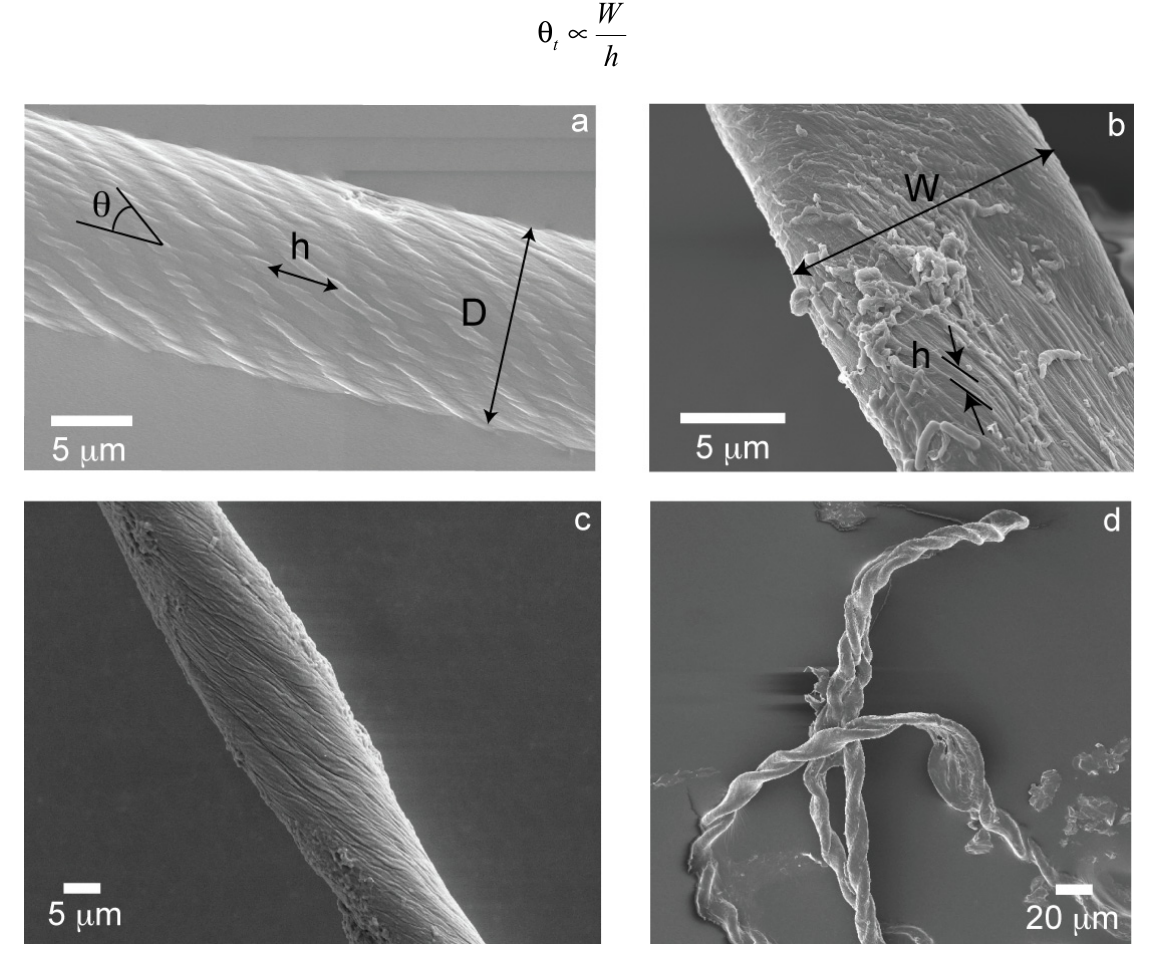
Figure 1. ( a ) THWG 37 °C, pH8 cylindrical fiber; ( b ) THGd:Al 0.36:0.64 flat tape; ( c ) THGd:My 0.36:0.64 22 °C elliptical fiber; ( d ) P7 highly twisted